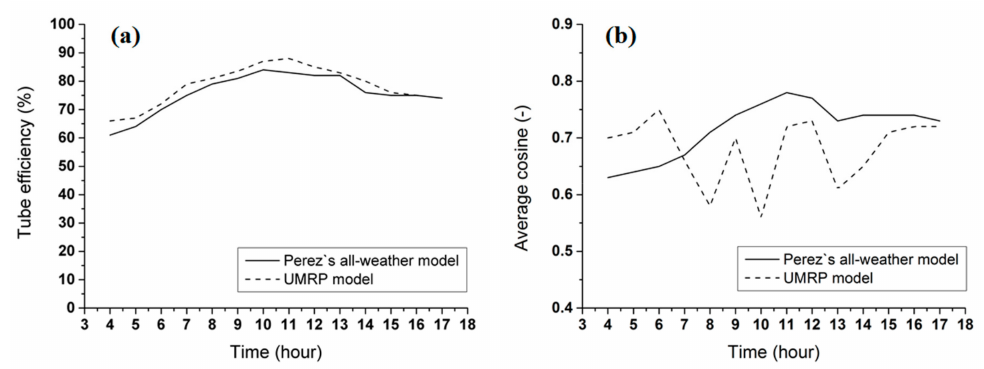
Figure 9. The same as in Figure 6, but for a partly cloudy day, 9 April 2015.